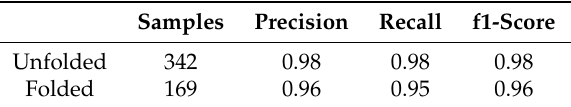
Table 1. Test set results of the linear classifier that detects whether the cloth has been folded (511 samples). The high classification performance means that the smart textile is suitable to be used as a reward function. Samples Precision